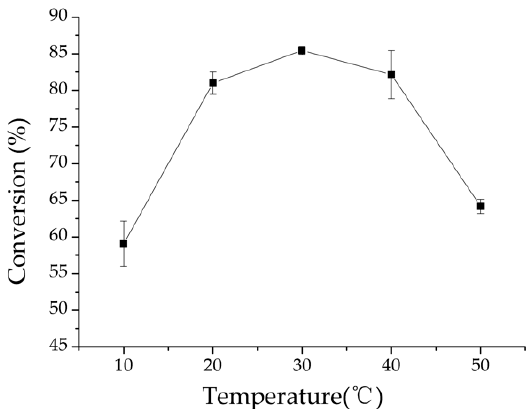
Figure 4. Optimization of temperature in terms of conversion of mannose with polyphosphate- dependent mannose kinase, mannose (20 g/L), (NaPO 3 ) 6 (60 g/L), and MgCl 2 (5 mM) at pH 8.5. Extreme temperatures would inhibit the reaction, and the highest conversion efficiency was 85.46% at 30 °C.